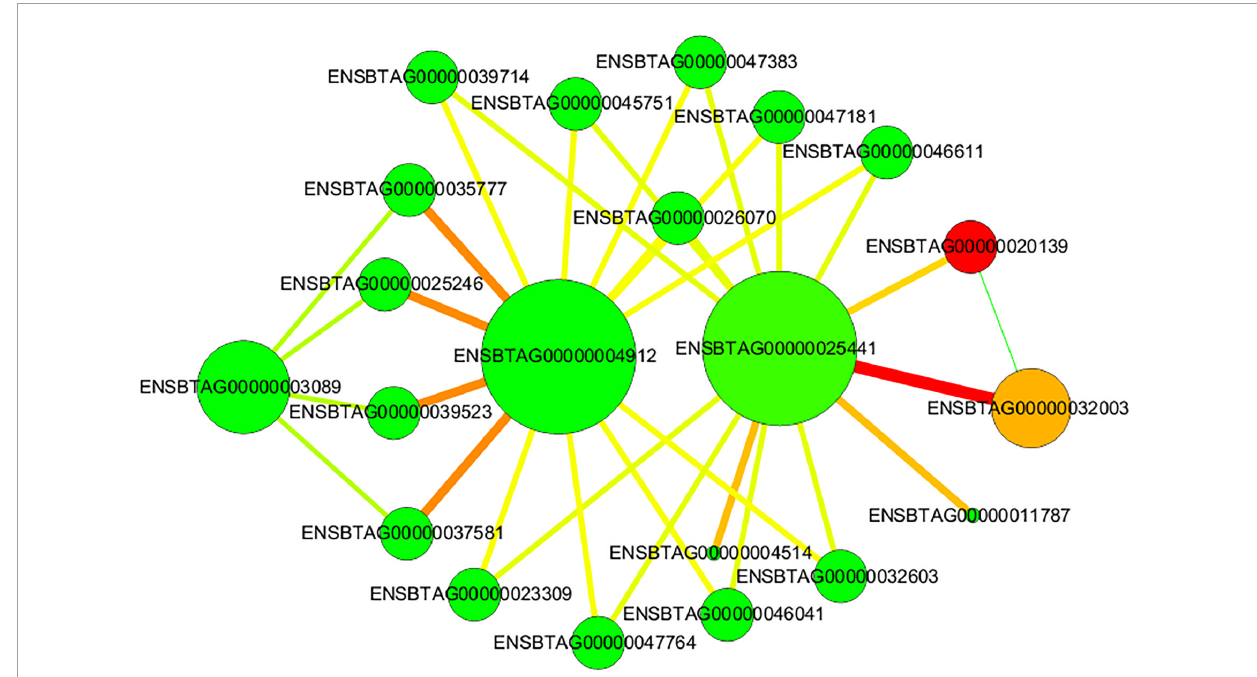
FIGURE6 Protein-protein interaction (PPI) networks of DEGs. The nodes represent proteins and the lines represent interactions. The size of node represents the degree. The color of node represents the cluster coefficient, values vary from low to high with the color gradient from green to red. The green line indicates conserved neighborhood evidence, the red line indicates fusion evidence, and the yellow-green line indicates text mining.